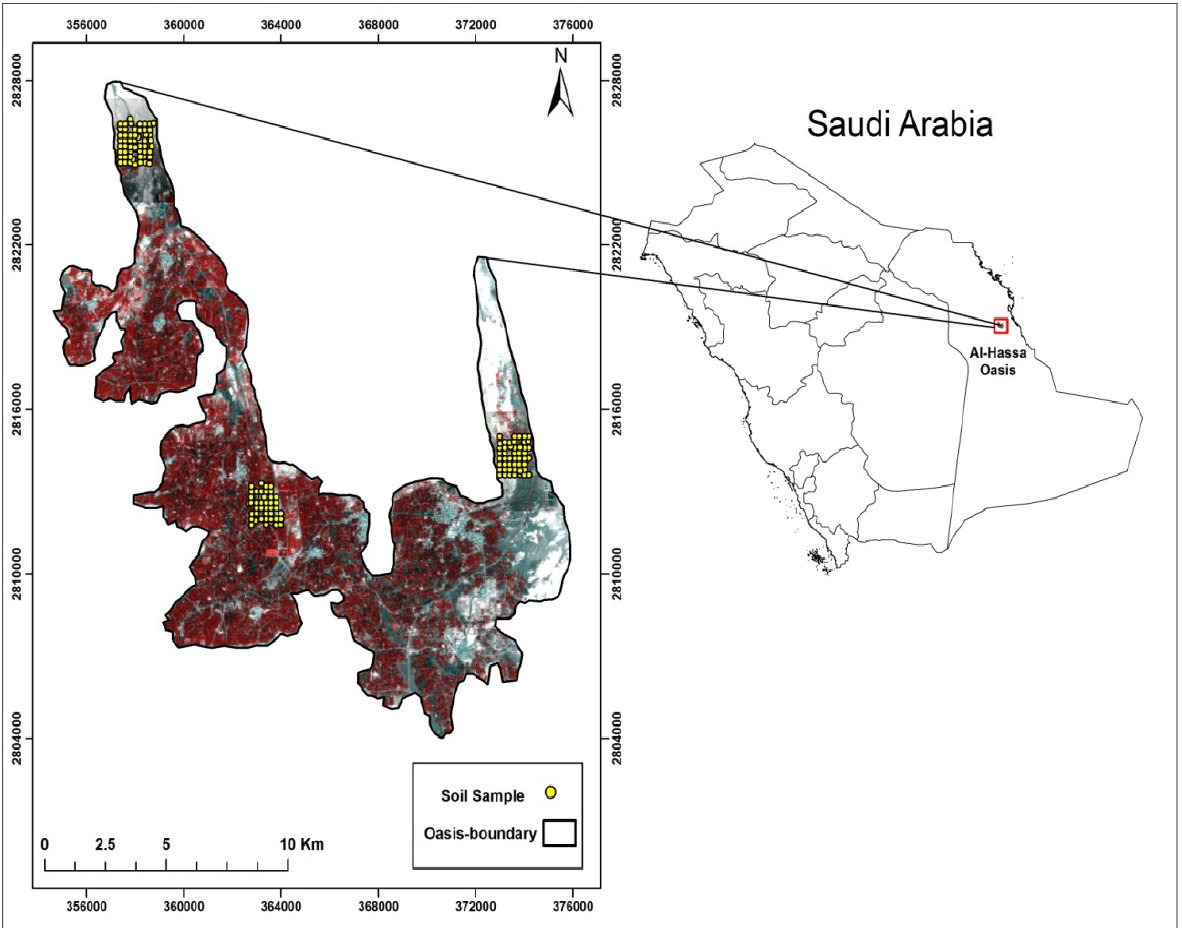
Figure 1. Study area with the location of the study